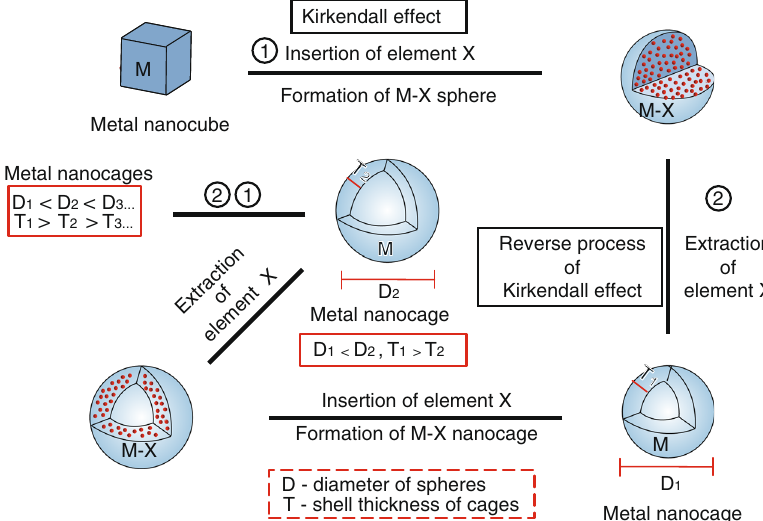
Fig. 1 Schematic illustration of the synthetic strategy of hollow metal nanocrystals. Schematic illustration of the repeated Kirkendall cavitation process that leads to the formation and enlargement of hollow monometallic